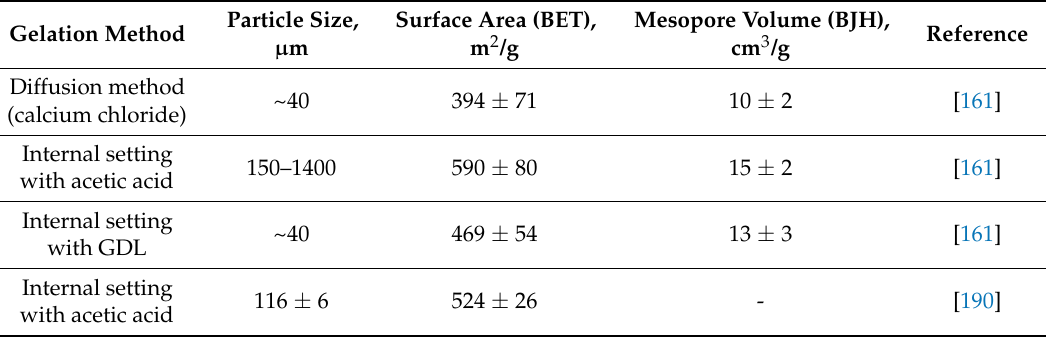
Table 2. Physical properties of aerogels of alginate particles obtained from references